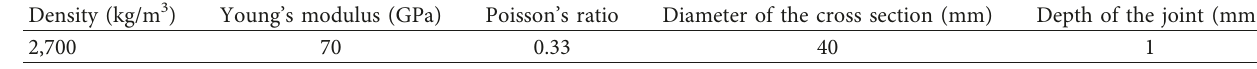
Table 1: Physical parameters of the aluminum specimens.